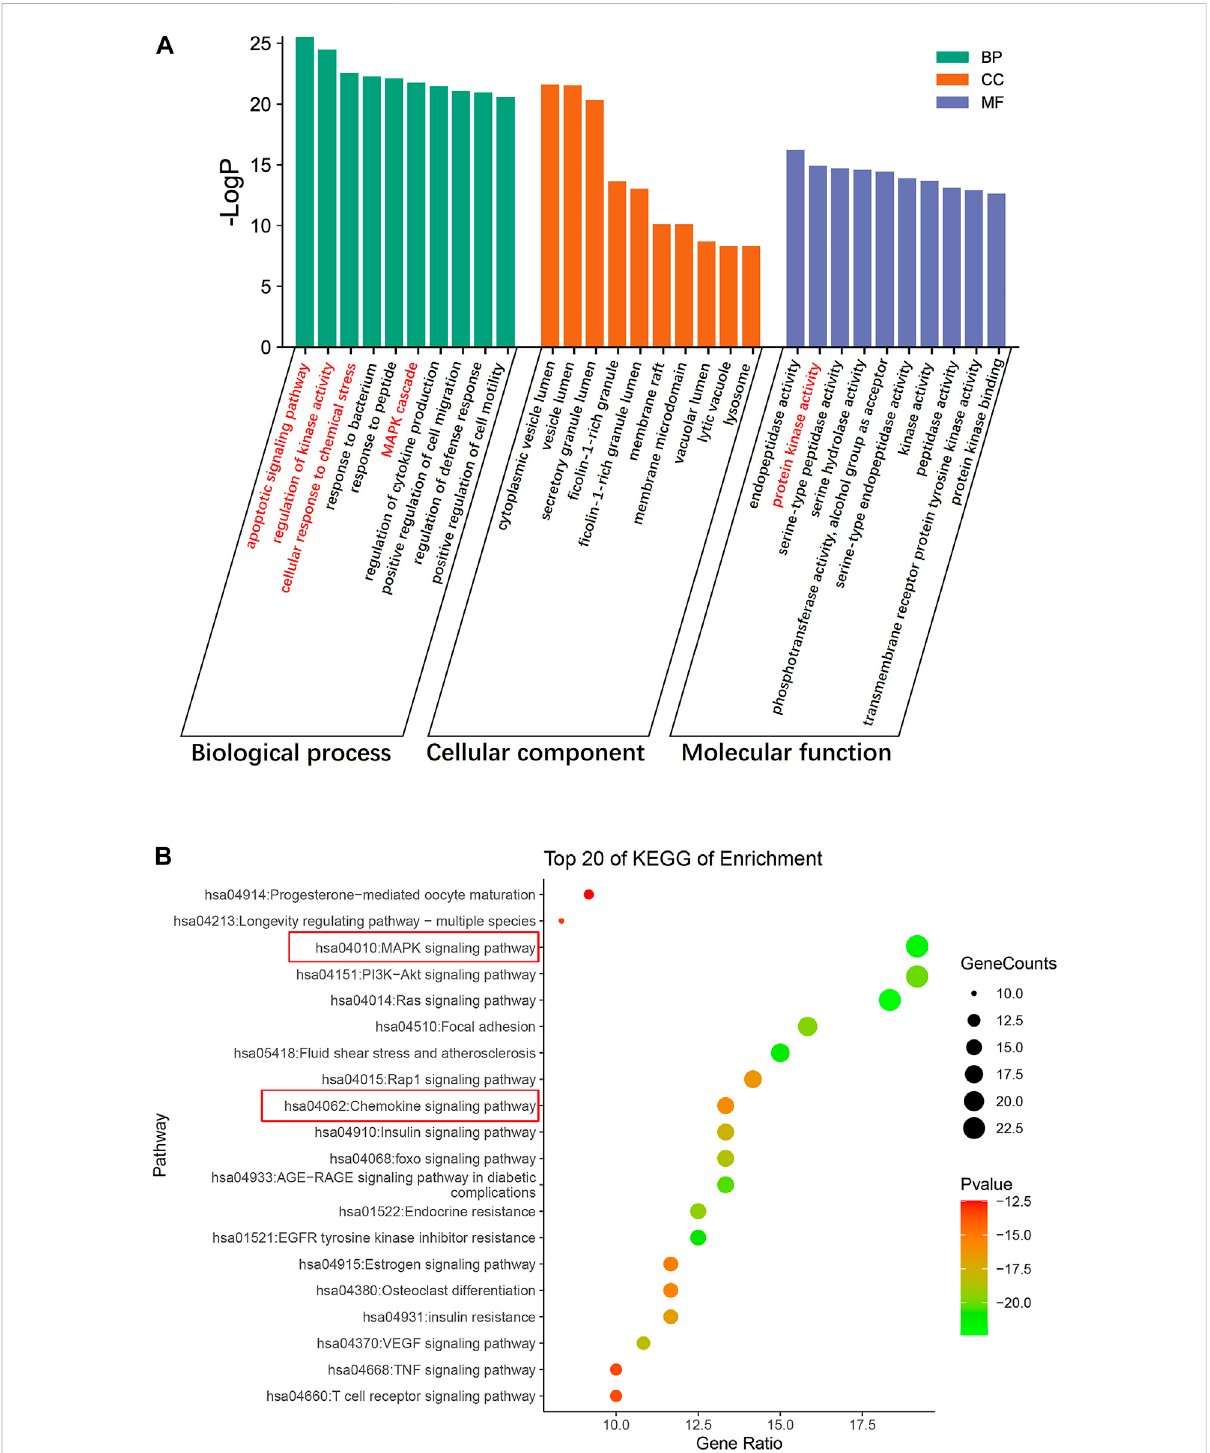
FIGURE 4 Enrichment analysis of the targets of CaD in treating DKD. (A) GO functional analysis. Top 10 items of each part are shown. (B) KEGG pathway enrichmentanalysis.Thesizesofthebubbles areillustratedfrombigtosmallinadescendingorderofthenumberofpotential targets involved inthe